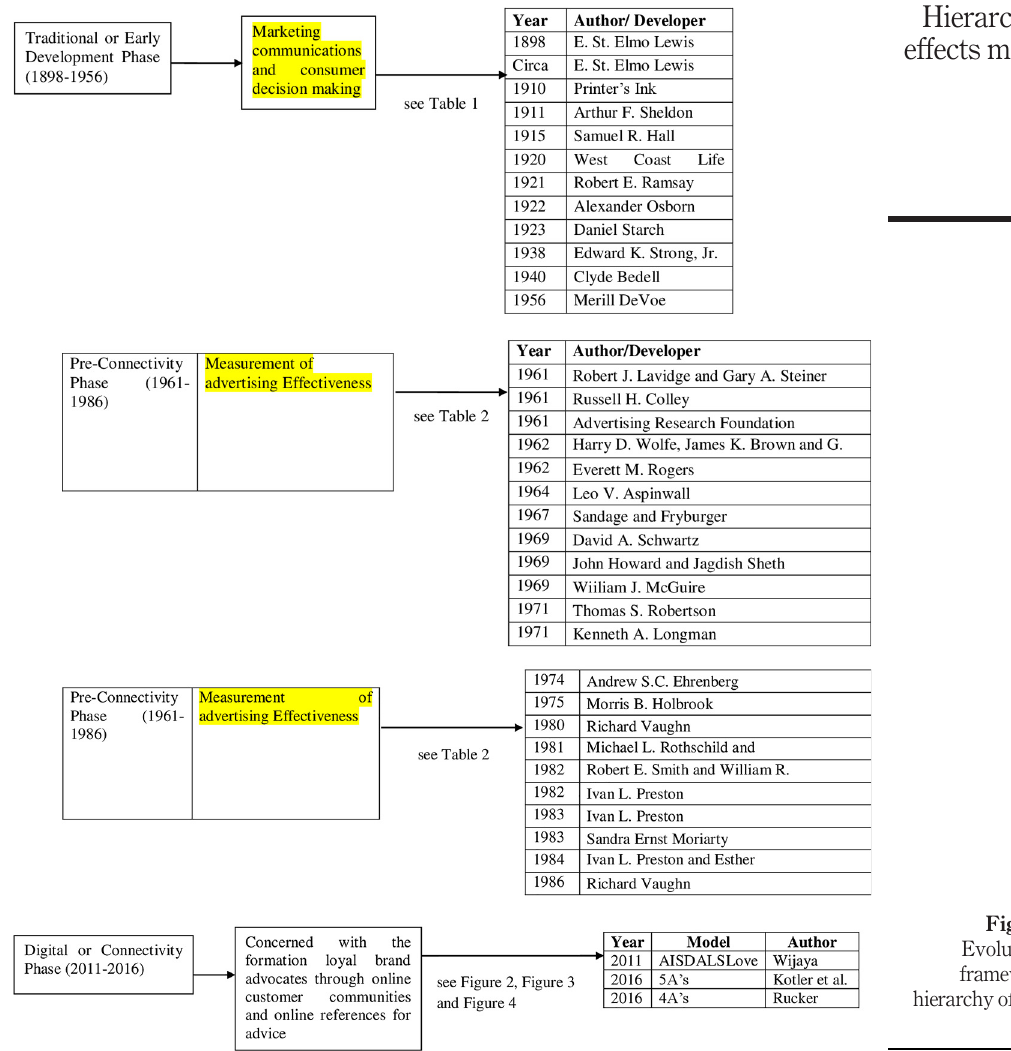
Figure 5. Evolutionary framework of hierarchy of effects